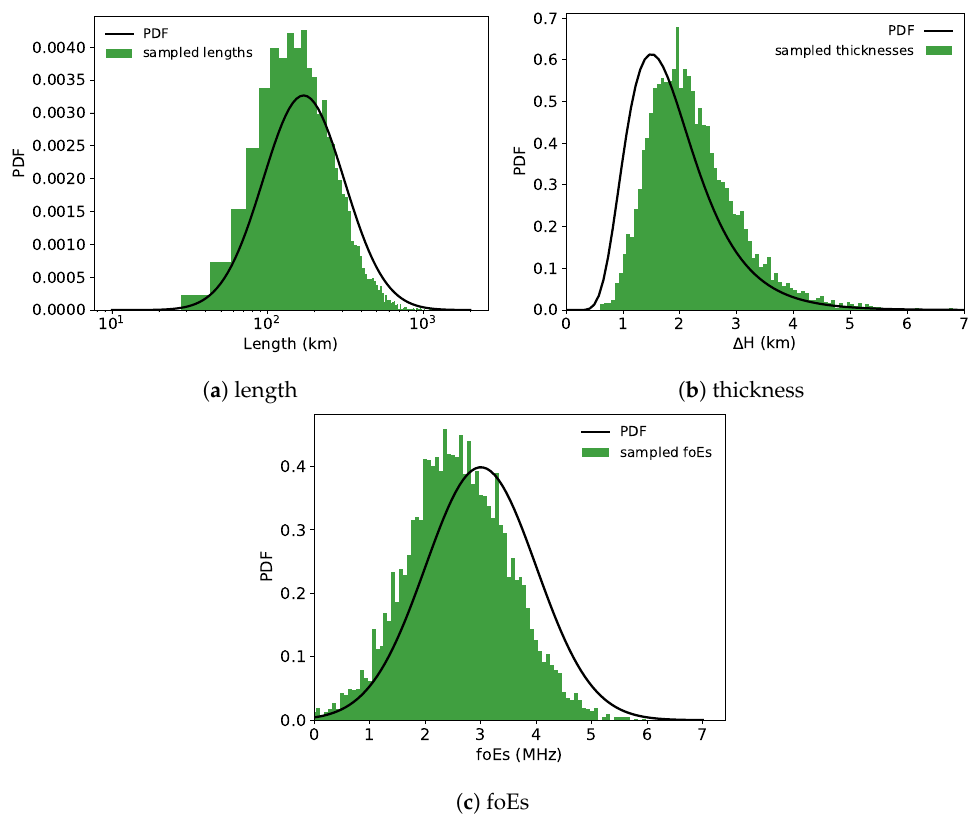
> 13.5 rad/km 2 were removed. Figure 10. Same as Figure 5 except strong, thin layers with φ 0 / r 2 0 The simulated S 4 - σ φ histograms for these diffusion-limited layers are displayed in Figure 11. Compared with the original distributions used to create Figure 6, the strong phase scintillation region with elevated S 4 and low σ φ was greatly reduced. Similarly, the S 4 - σ φ histograms for the turbulent lenses were also improved by the removal of layers > 13.5 rad/km 2 (Figure 12). While the strong phase scintillation region was with φ 0 / r 2 0